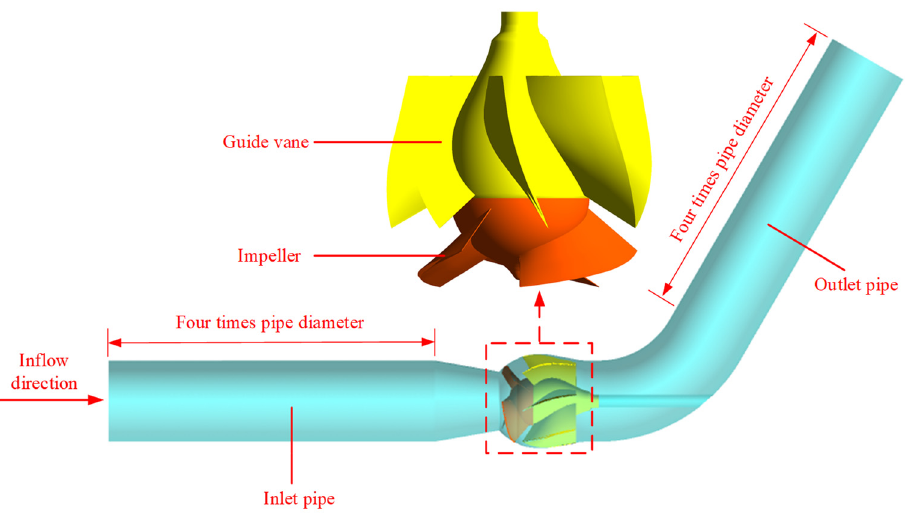
Figure 1. Three ‐ dimensional model of the mixed ‐ flow pump. Figure 1. Three-dimensional model of the mixed-flow